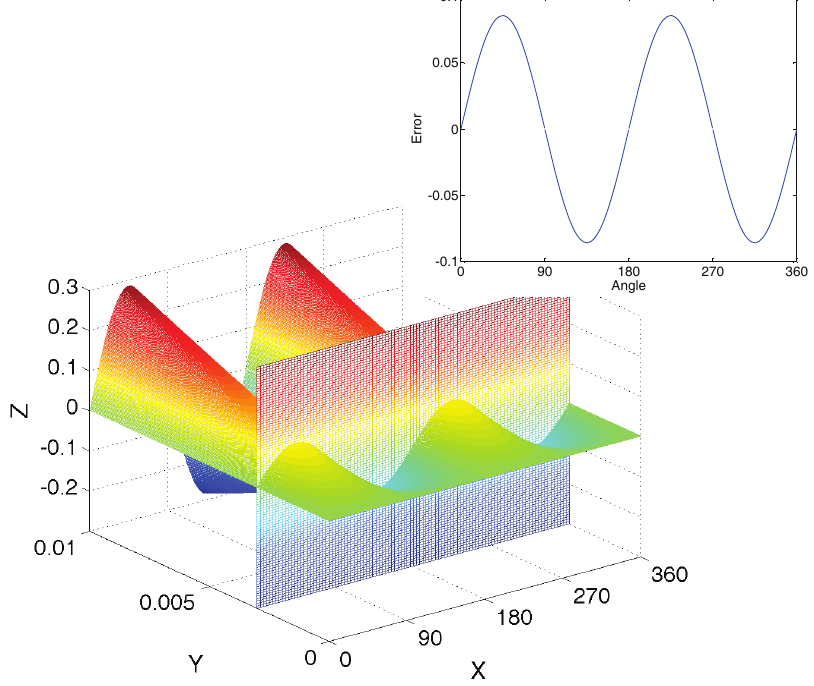
Figure 4. The influence of gain mismatch. The x-axis is the angle from 0 ◦ to 360 ◦ . The y -axis is the percentage of mismatch from 0% to 1%. The x -axis is the relative error.